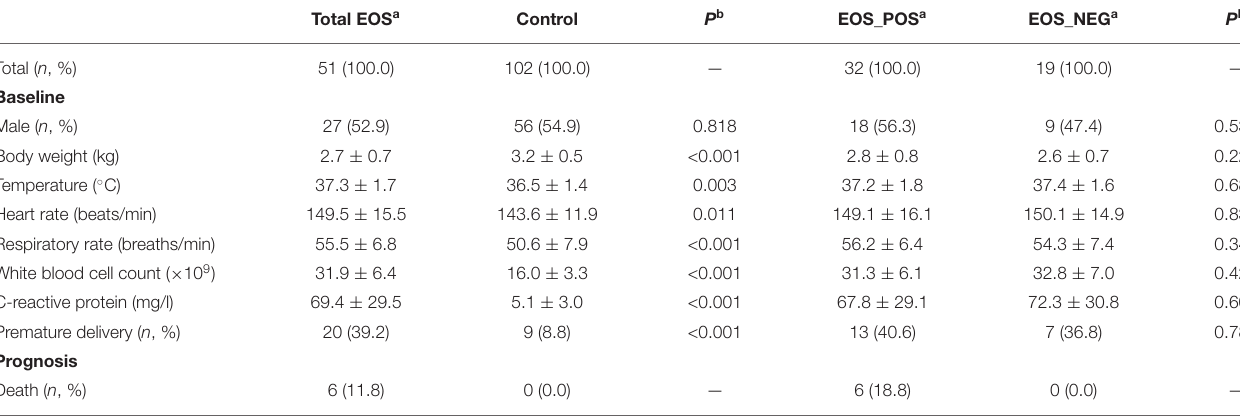
TABLE 1 | Characteristics of newborns with early-onset neonatal